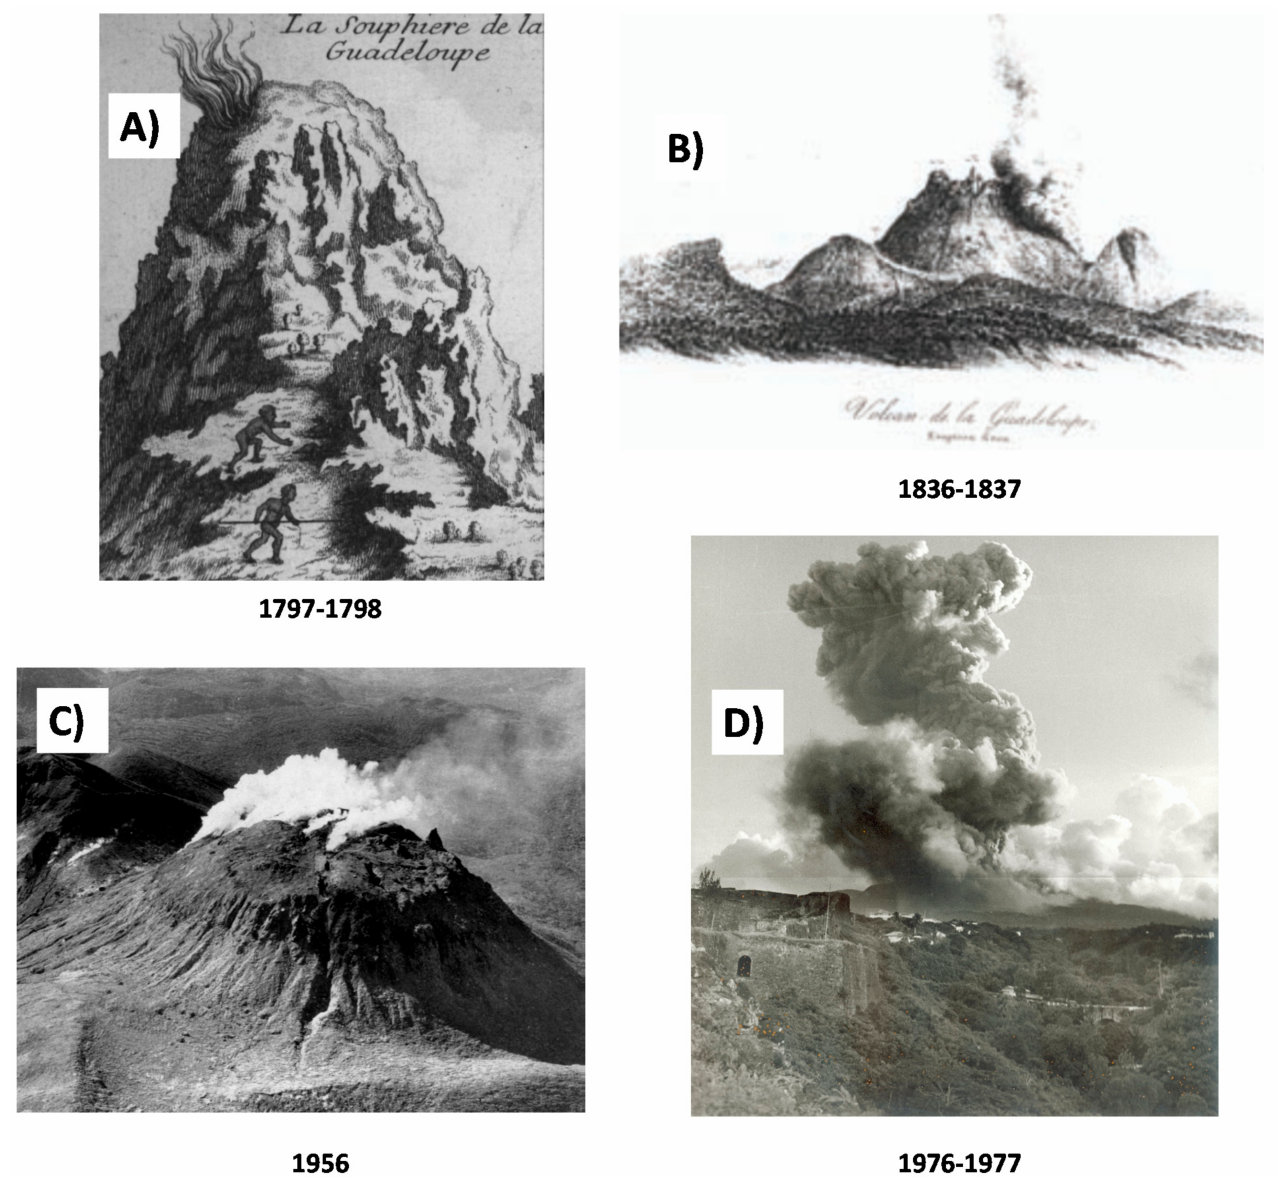
Figure 3. Images of historic phreatic eruptions; based on pictures ( A – D ) from Labat (1732), Biot et al. (1837), Barab é and Jolivet (1958), and M. Feuillard (OVSG-IPGP database). See also Komorowski et al. (2005)